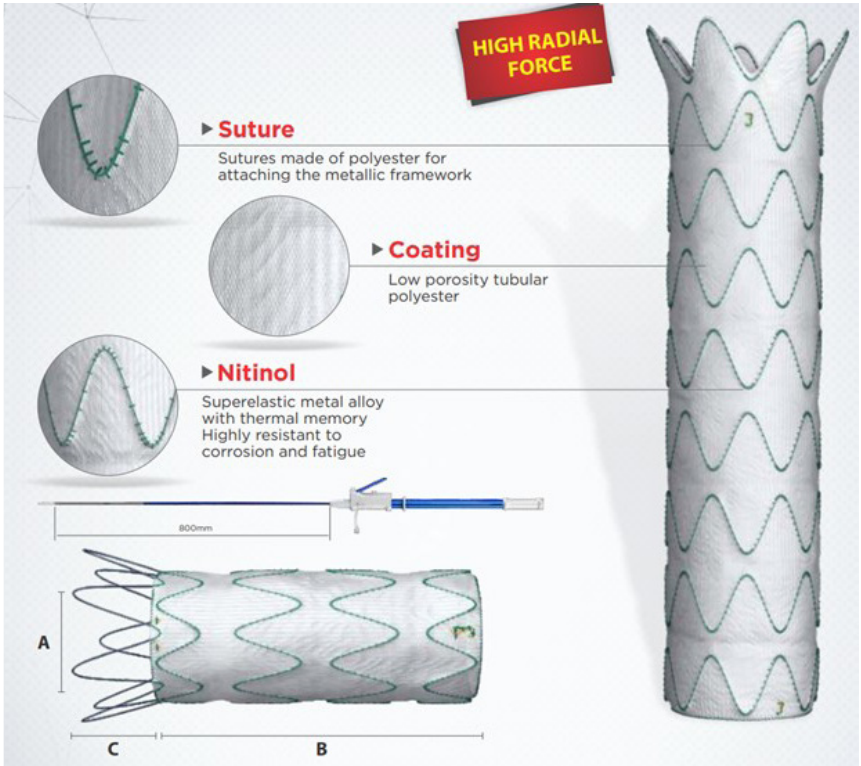
Fig. 1 - Braile Dominus® Coarctation Aorta endoprosthesis